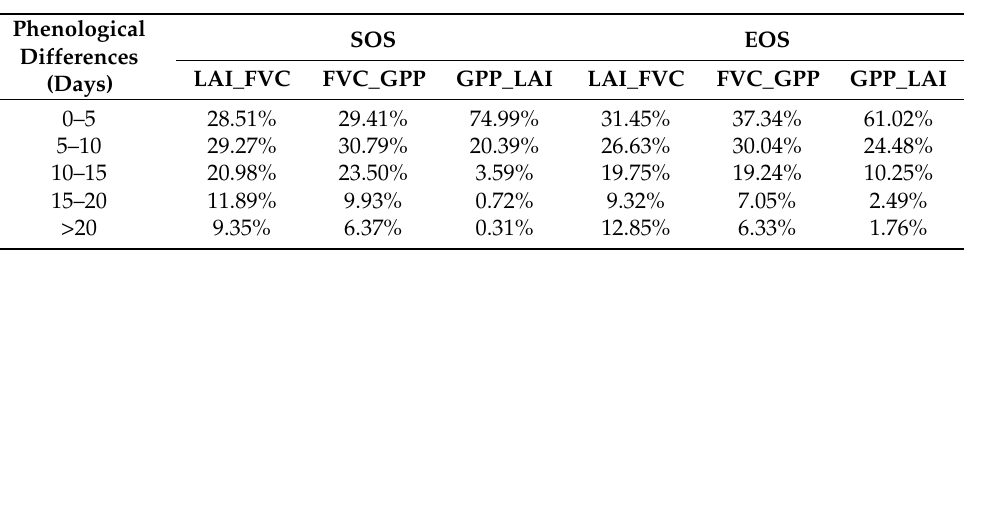
Table 2. The statistical distribution of absolute difference (days) of SOS and EOS between every two